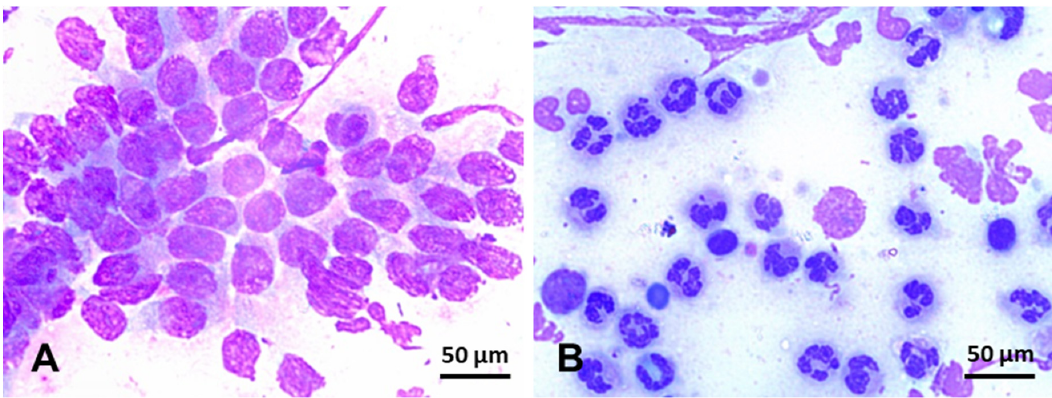
Figure 5. Endometrial cytology in mares stained with Romanowsky-type stain (×100). ( A ) Negative endometrial cytology; in this slide, endometrium epithelium cells, can be seen in the absence of inflammatory cells. ( B ) Positive endometrial cytology; few endometrium epithelium cells can be seen in this slide, but, conversely, hypersegmented neutrophils are overly represented in this smear. Scale bars 50 µm ( A and B ).